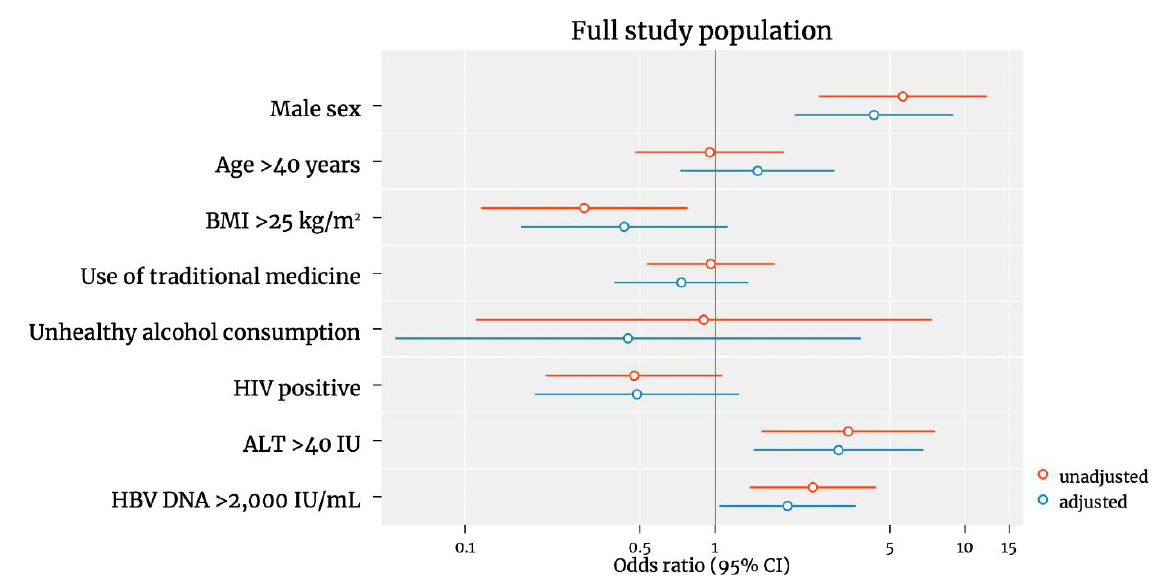
Figure 2. Predictors of significant liver fibrosis in the full study population. Odds ratios were plotted on a logscale.